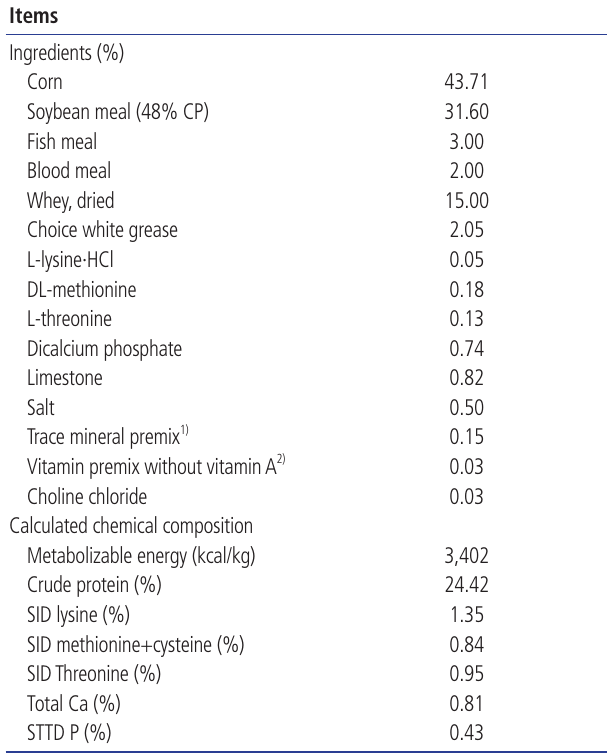
Table 1. Diet formulation and calculated chemical composition